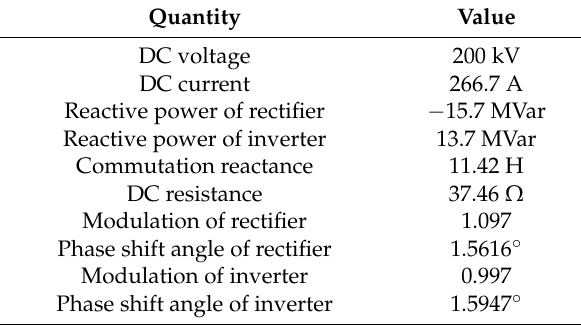
Table 2. Basic operating parameters of the VSC-HVDC (Voltage Sourced Converter-High Voltage Direct Current) system.